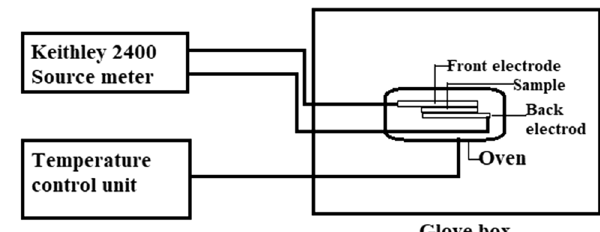
Fig.3 Schematic circuit dia- gram of temperature-depend-